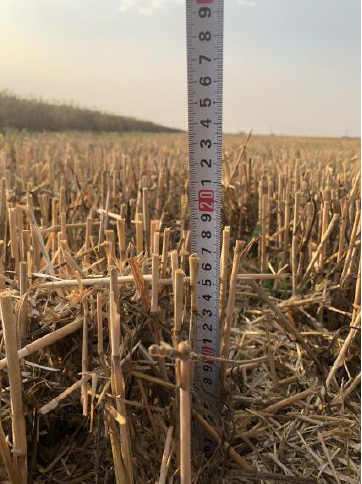
Figure 19. Manual collection cutting height.